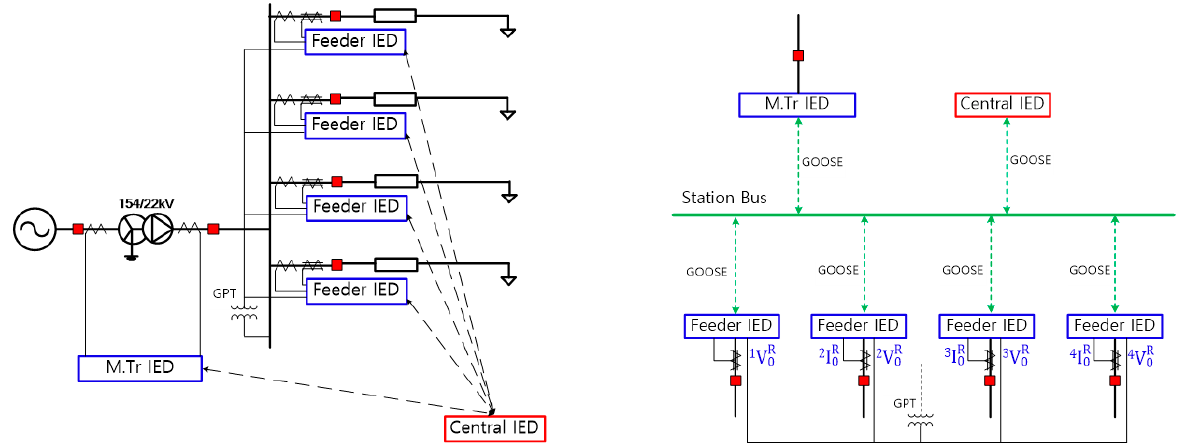
Figure 6. Configuration of the International Electrotechnical Commission (IEC) 61850-based centralized protection scheme with intelligent electronic devices (IEDs).